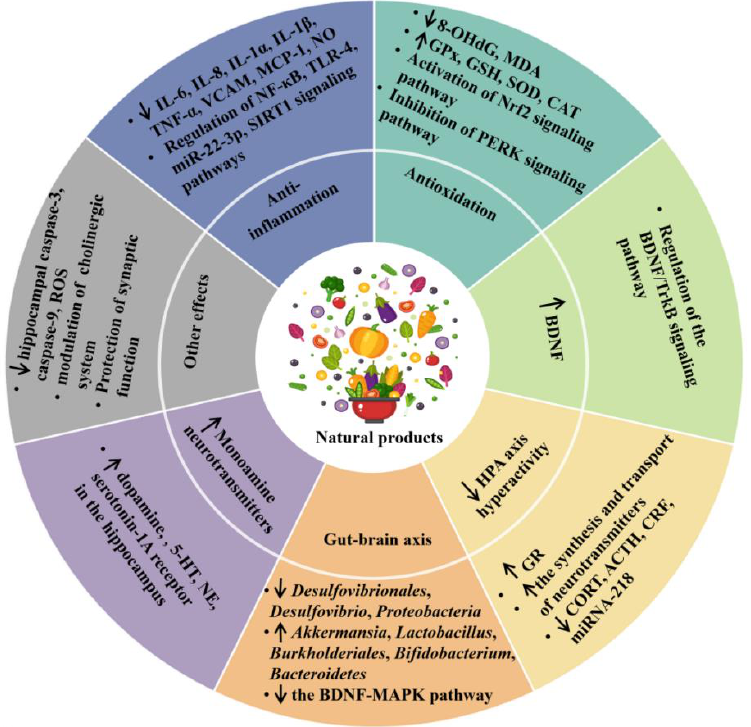
Figure 1. The effects and mechanisms of dietary natural products on depression. ↑ represents increase, and ↓ represents decrease. ACTH, adrenocorticotropic hormone; BDNF, brain-derived neurotrophic factor; CAT, catalase; CORT, corticosterone; CRF, corticotropin-releasing factor; GPx, glutathione peroxidase; GR, glucocorticoid receptor; GSH, glutathione; 5-HT, serotonin; IL, interleukin; MAPK, mitogen-activated protein kinase; MCP-1, macrophage chemoattractant protein 1; MDA, malondialdehyde; NE, norepinephrine; NF- κB, nuclear factor kappa -B; NO, nitric oxide; Nrf2, nuclear erythroid related factor 2; 8-OHdG, 8-hydroxydeoxyguanosine; PERK, protein kinase-like endoplasmic reticulum kinase; ROS, reactive oxygen species; SCFA, short-chain fatty acids; SIRT1, Sirtuin 1; TNF- α, tumor necrosis factor - α; SOD, superoxide dismutase; TrkB, tyrosine kinase receptor B; VCAM, vascular cell adhesion molecule.